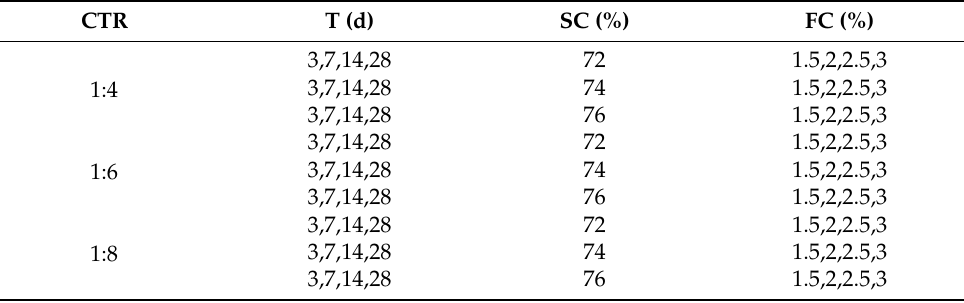
Table 3. Mix proportions of prepared FCPB